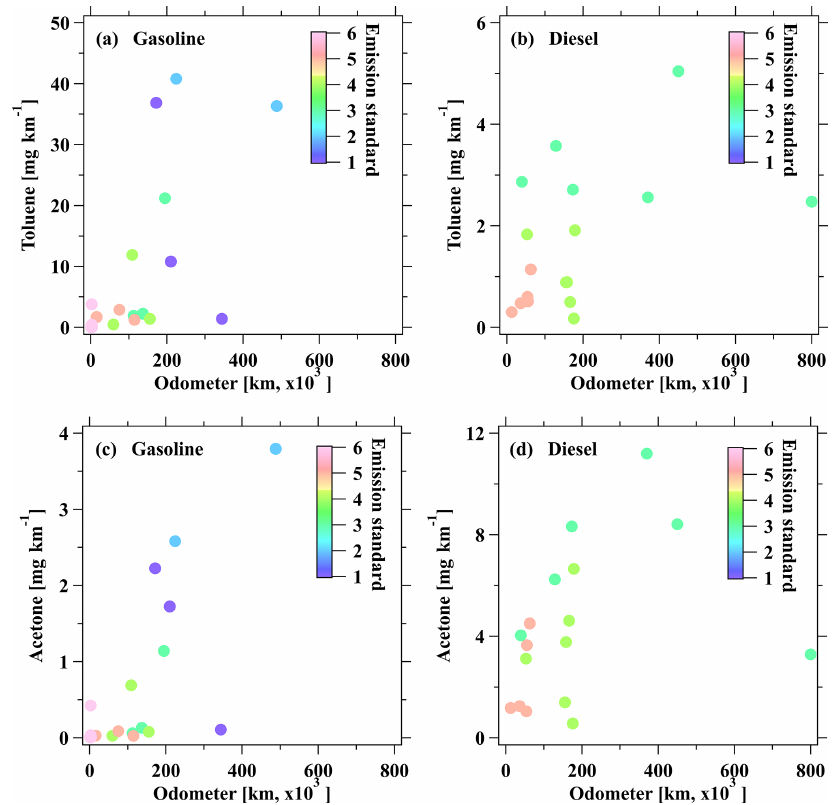
Figure 3. Scatterplot of the emission factors of toluene in (a) gasoline and (b) diesel vehicles, as well as acetone in (c) gasoline and (d) diesel vehicles during the hot start based on the odometer for each vehicle.